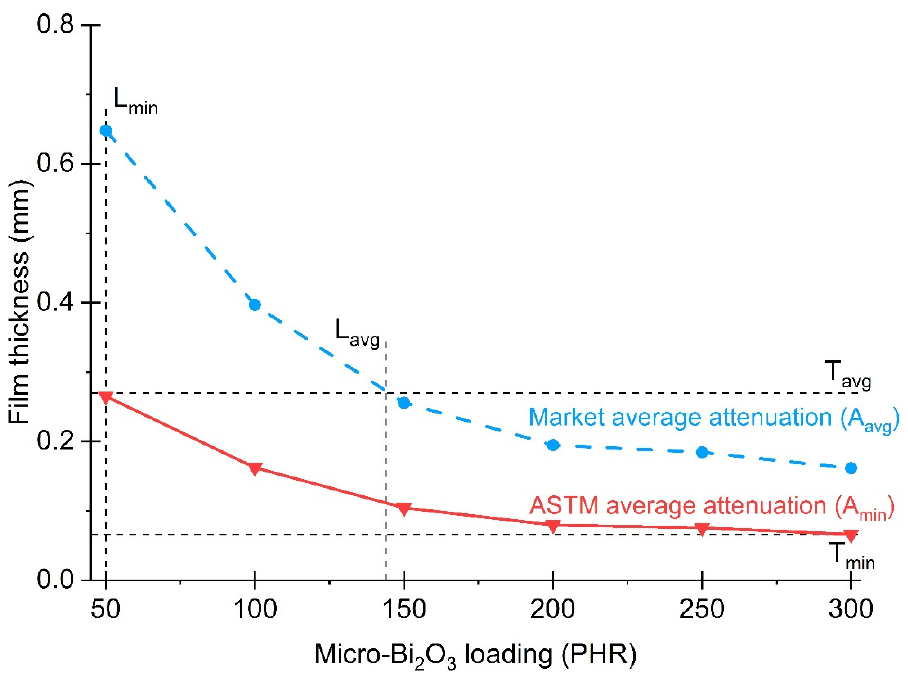
Figure 8. ASTM average attenuation and market average attenuation isocontour curves as a function of GNRL/micro-Bi 2 O 3 film thickness and micro-Bi 2 O 3 loading.